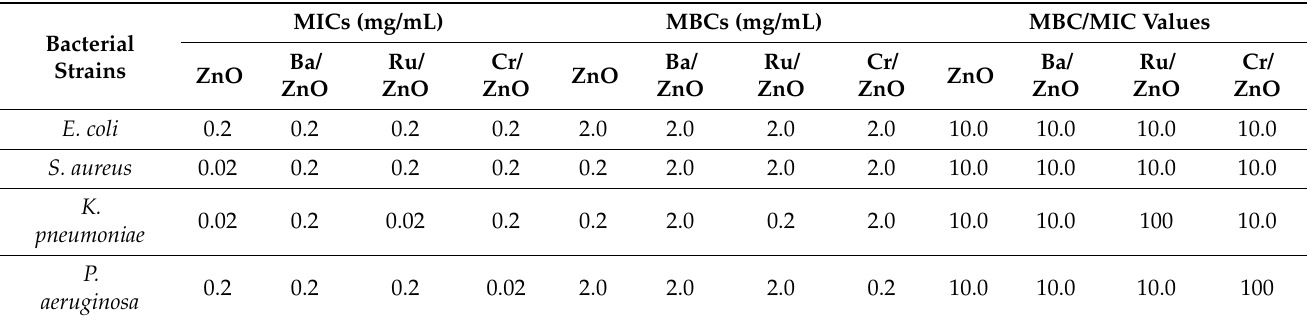
Table 3. The MIC, MBC, and MBC/MIC values for the